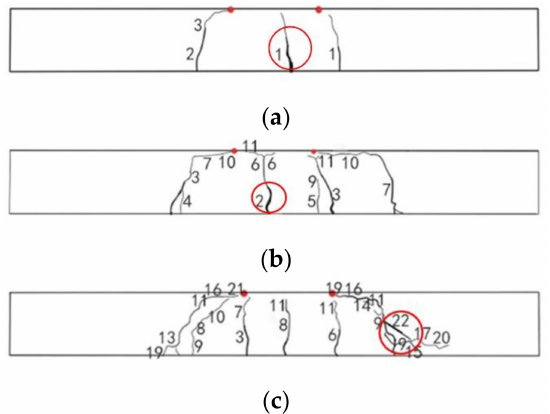
Figure 7. Crack distribution on side A surface of SSC beams (the two red points are loading points):